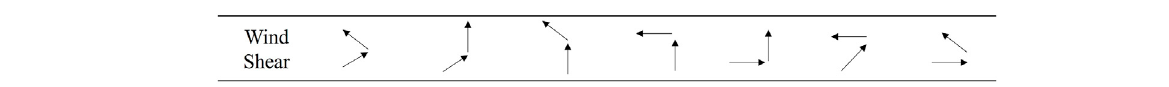
FIGURE 2 | Schematic diagram of wind direction shear for the warm shear line over YHR.